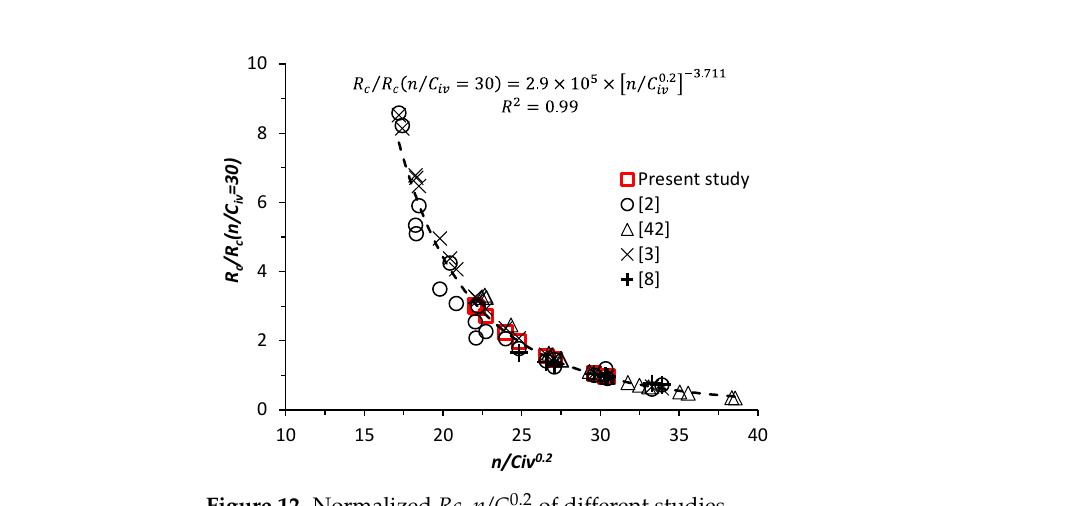
Figure 12. Normalized Rc–n/C 0.2 of different studies. iv Table 6. CBS research studies found in the literature.